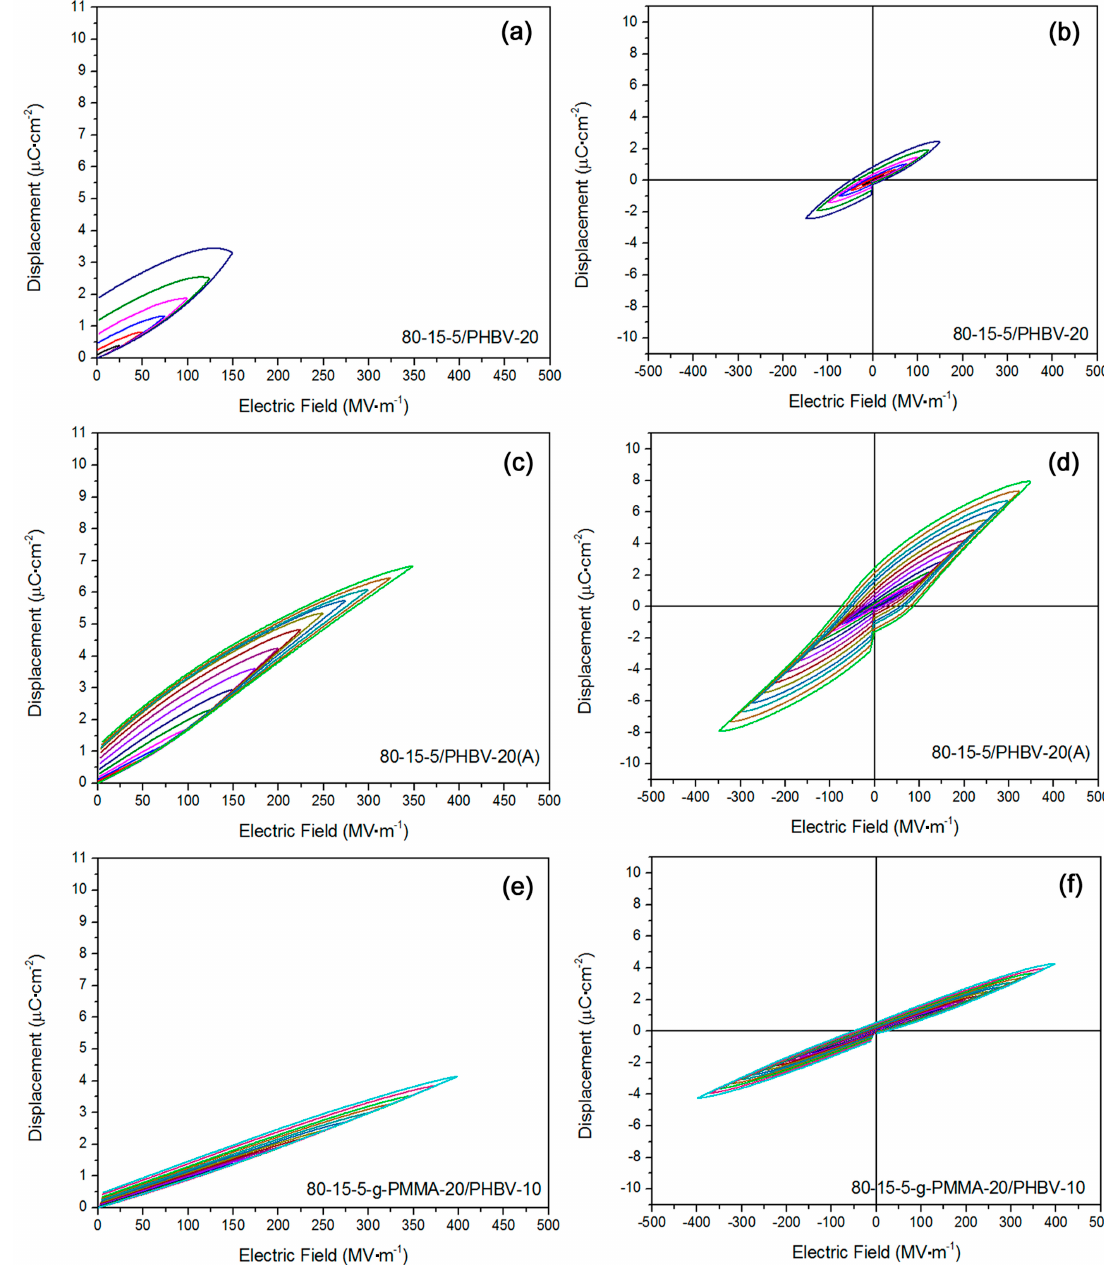
Figure 3c,d. That was ascribed to the rigidity restriction effect of PMMA on the reversal of dipoles in